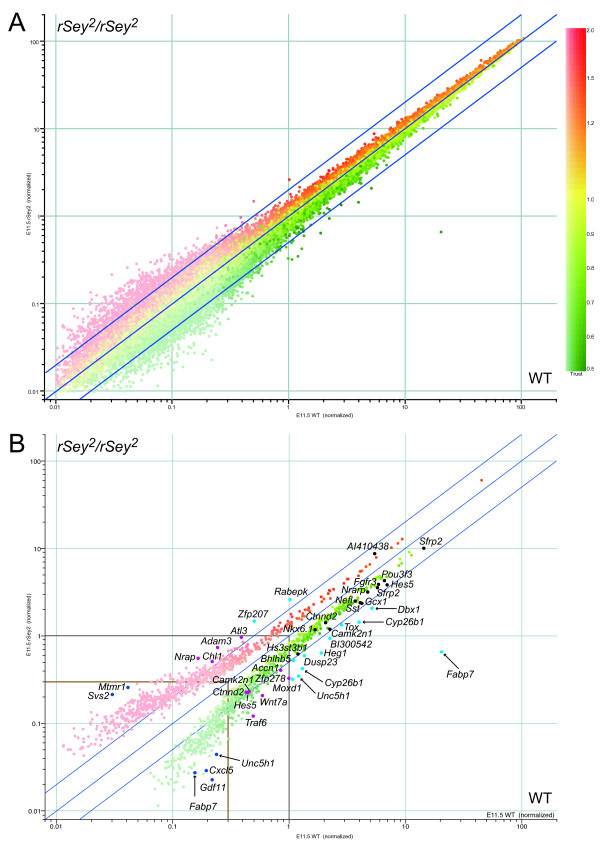
Scatter plots of gene expression levels in the hindbrain of E11.5 rSey2/rSey2 and WT rat embryos. (A) Average per chip normalized signal intensities for all probe sets on GeneChip 230A and 230B are plotted using GeneSpring software. The dots are colored according to their per gene normalized values for rSey2/rSey2 (vertical) compared to WT (horizontal): high (red), equal (yellow) and low (green). The reliability of the data is indicated by a dark-light gradient; genes with higher confidence are deeper in color. The three blue lines correspond to 2-fold up-regulation (+2), no change (± 1) and 2-fold down-regulation (-2) for rSey2/rSey2 compared to WT. (B) The 1,421 differentially expressed genes selected by t-test using the cross-gene error model (p < 0.05). Gray and brown lines indicate the normalized signal as 1 and 0.3, respectively. Cyan, black, magenta and blue dots with gene names correspond to the probe sets that are listed in Additional file 4 and displayed in Figure 3. The colors of the dots reflect expression levels and fold change values: cyan, high expression (normalized signal > 1) with more than a 2-fold change; black, high expression with less than a 2-fold change; magenta, medium expression (normalized signal 0.3 to 1); and blue, low expression (normalized signal < 0.3) with more than a 5-fold change. The seven probe sets indicated with arrows correspond to four of the most down-regulated genes, which are shown in situ in Figures 4 and 5.